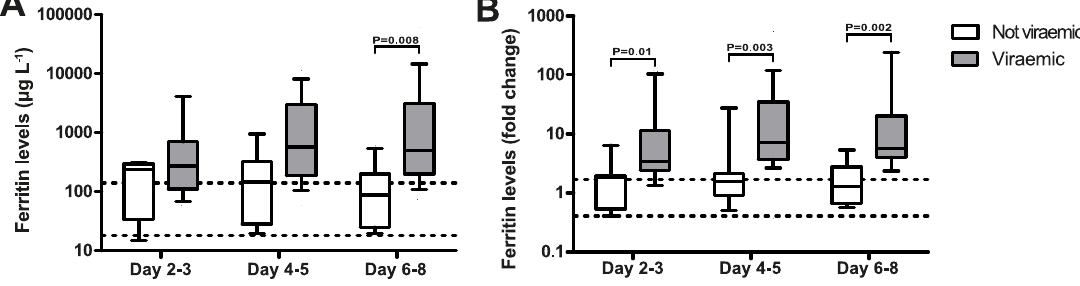
Figure 2. Ferritin levels and fold change are associated with viraemia. The absolute ferritin levels were significantly increased in viraemic patients compared to non-viraemic patients at day 6–8 (A) and the ferritin fold change was significantly elevated in viraemic patient at each time point (B) in the cohort from Aruba. Area between two dotted horizontal lines: interquartile range from the autologous control group. Boxplots indicate the interquartile range. The horizontal line inside the box indicates the median. The whiskers reach from the 10 th till the 90 th percentile. P- value # 0.02 is considered significant.